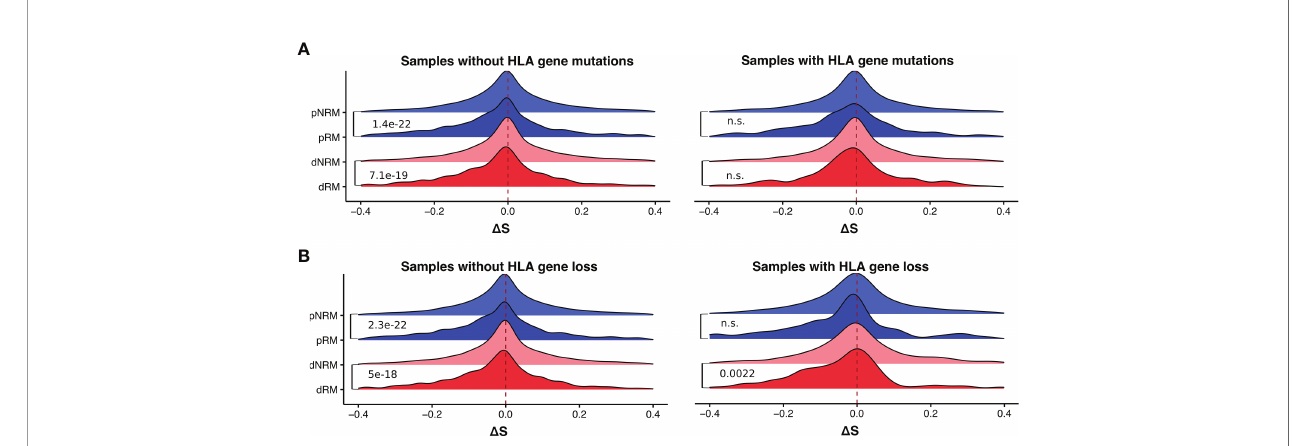
FIGURE 4 | Difference in MHC-I binding af fi nities of somatic mutations in melanoma samples with and without HLA gene de fi ciency. (A) The distribution of D S of somatic mutations in samples with and without HLA gene mutations. (B) The distribution of D S of somatic mutations in samples with and without HLA gene loss. dRM, recurrent mutation in driver genes; dNRM, non-recurrent in driver genes; pRM, recurrent mutation in passenger genes; pNRM, non-recurrent in passenger genes. P adj -values were calculated using two-sided Wilcoxon rank-sum tests and adjusted for multiple testing by the Holm – Bonferroni method. n.s., not signi fi